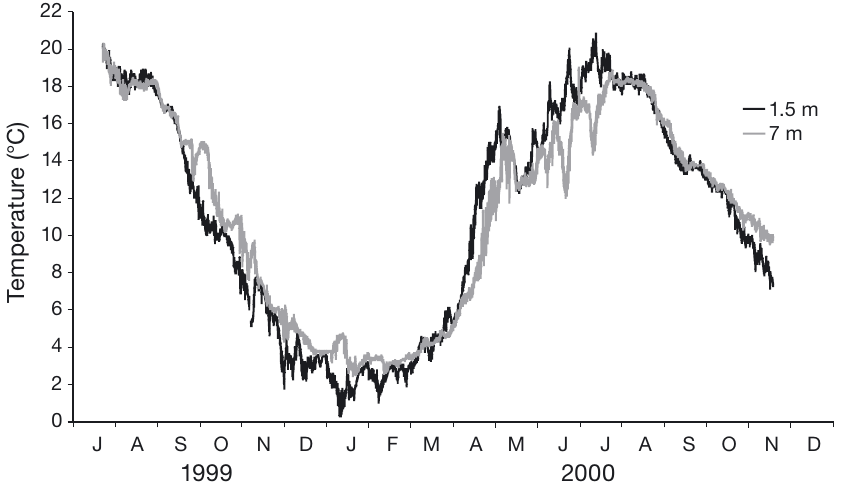
Fig. 3. Temperature at 2 depths (1.5 and 7 m) in the center of the culture unit during a production